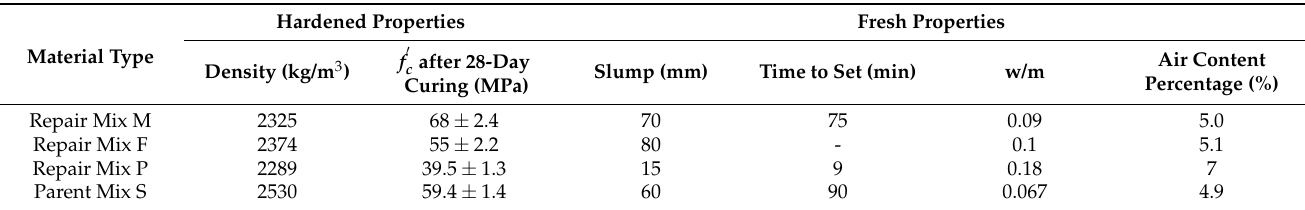
Table 2. Details of fresh and hardened properties of substrate and repair materials (Data from